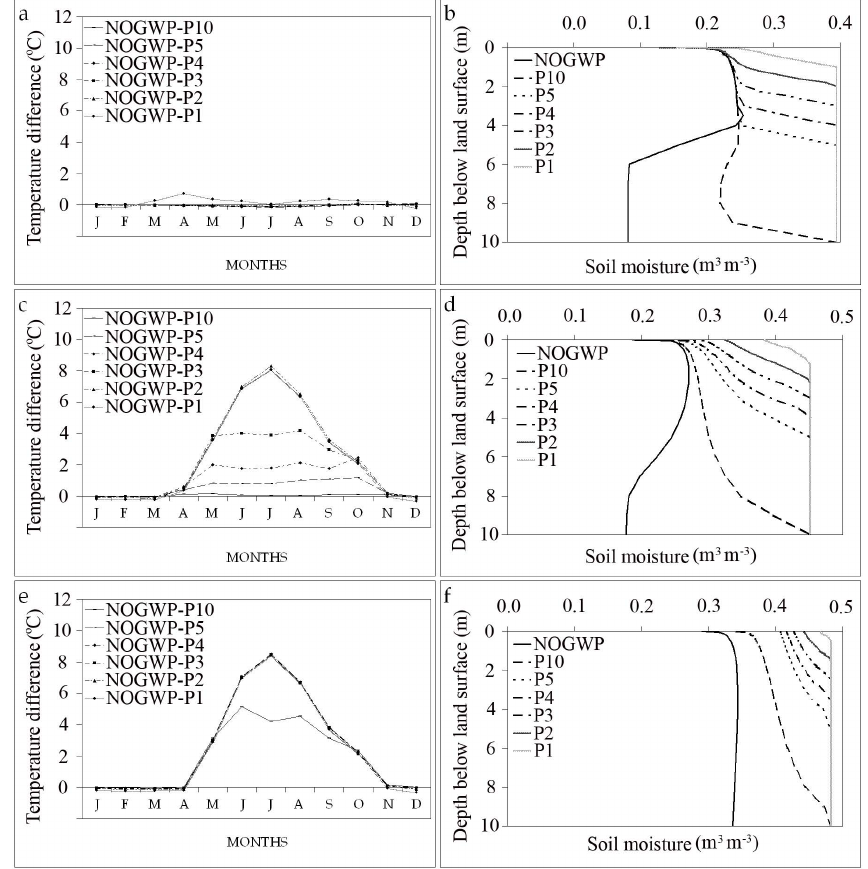
Fig. 7. The surface temperature differences between NOGWP and the profiles with water table at depths of 1, 2, 3, 4, 5 and 10m of (a) sand, (c) loam and (e) clay. (b) , (d) and (f) : the annual average soil moisture profiles of the three soil types